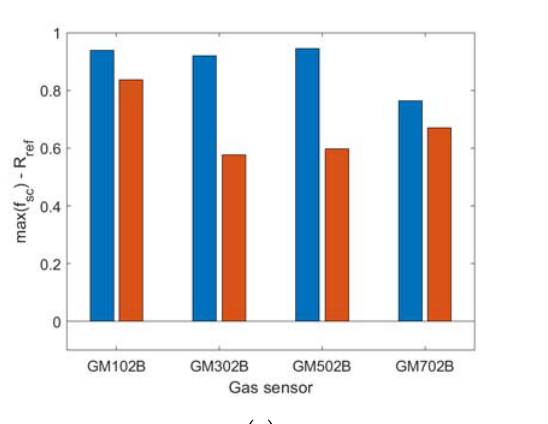
Figure 15. The magnitude of sensing drone response to air pollution when the sensing platform was lowered to the measurement point (blue bar) and when it was docked under the drone (red bar) during measurement, based on experiments: ( a ) CE1 (branches burning), and ( b ) CE2 (touchwood burning).